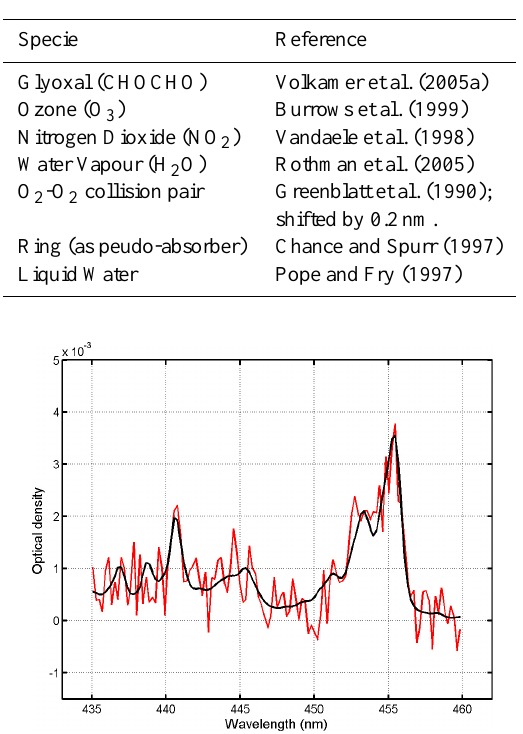
Table 1. Reference cross-section data sets included in the glyoxal DOAS retrievals.